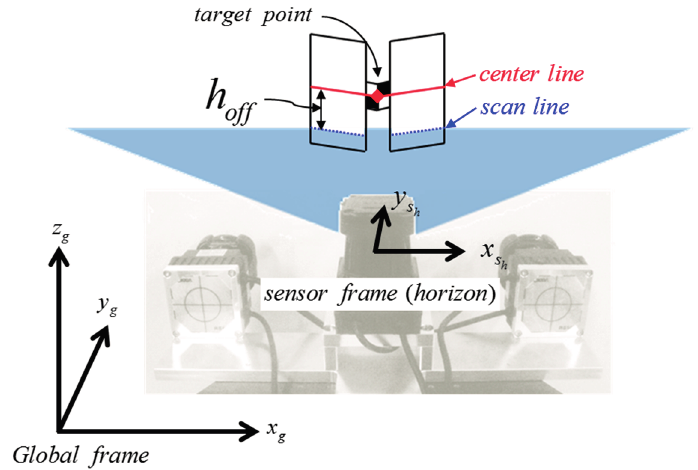
Figure 7. Conceptual figure of the horizontal target